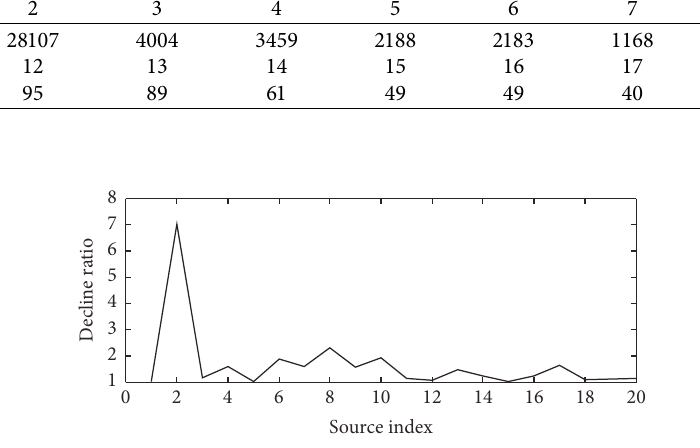
Figure 11: Changes of decline ratio with source index under experiment condition.